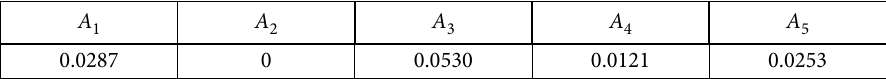
Table 16. The appraisal scores of the enhancement EDAS method based on the CPT